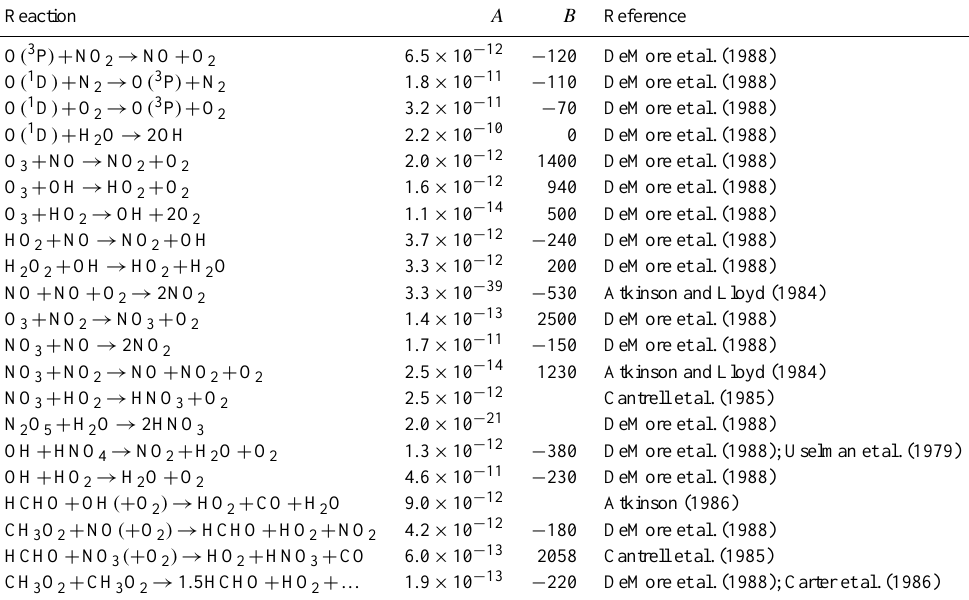
Table. C1. Gas phase reactions (from the RADM2 chemical mechanism, Stockwell et al., 1990) used in this work with a rate coef- ficient k(T ) = Ae − B/T . T is the temperature in Kelvin, the units of A are cm 3 s − 1 for second order and cm 6 s − 1 for third order reactions, the units of B are